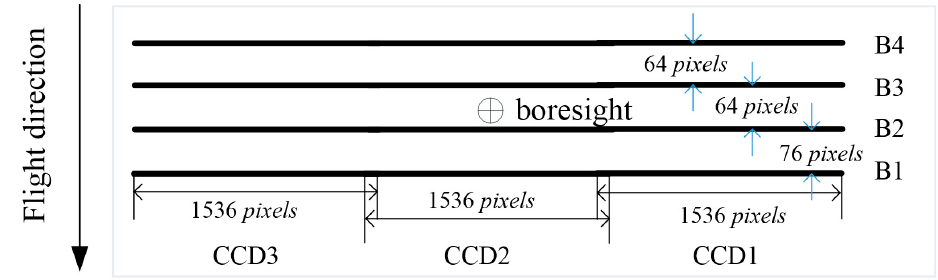
Figure 1. Diagrammatic sketch of the multispectral camera focal plane of Gaofen-1 02/03/04 satellites.